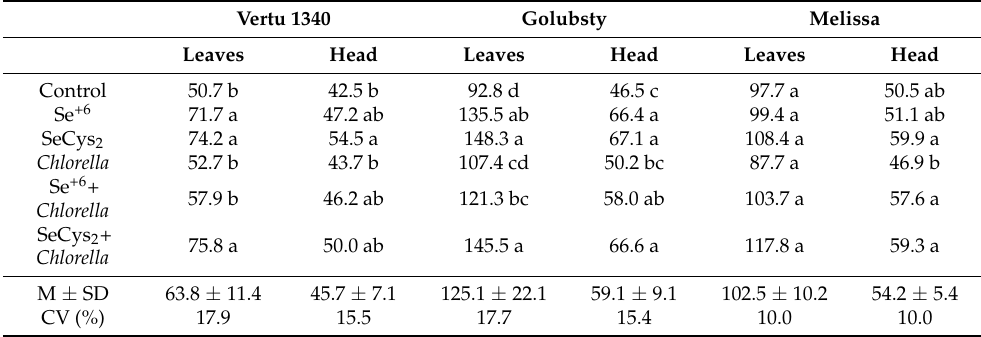
Table 3. Ascorbic acid accumulation in leaves and heads of Savoy cabbage under selenium and Chlorella supply (mg 100 g − 1 f.w.).